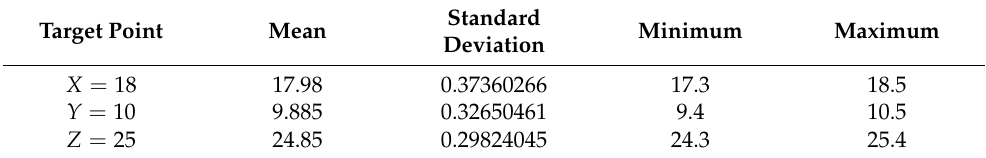
Table 7. Experimental repeatability test for the target point [18, 10, 25] statistical